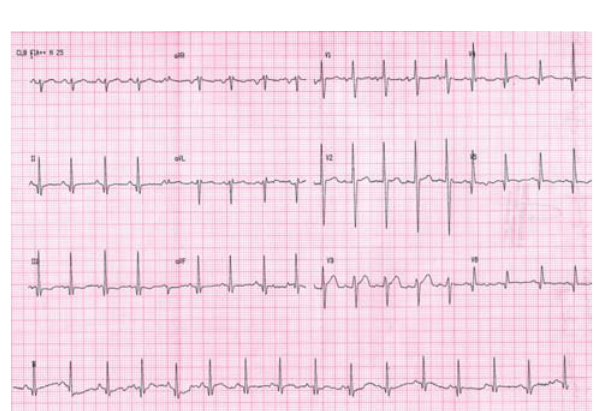
Fig. 1 – Eletrocardiograma